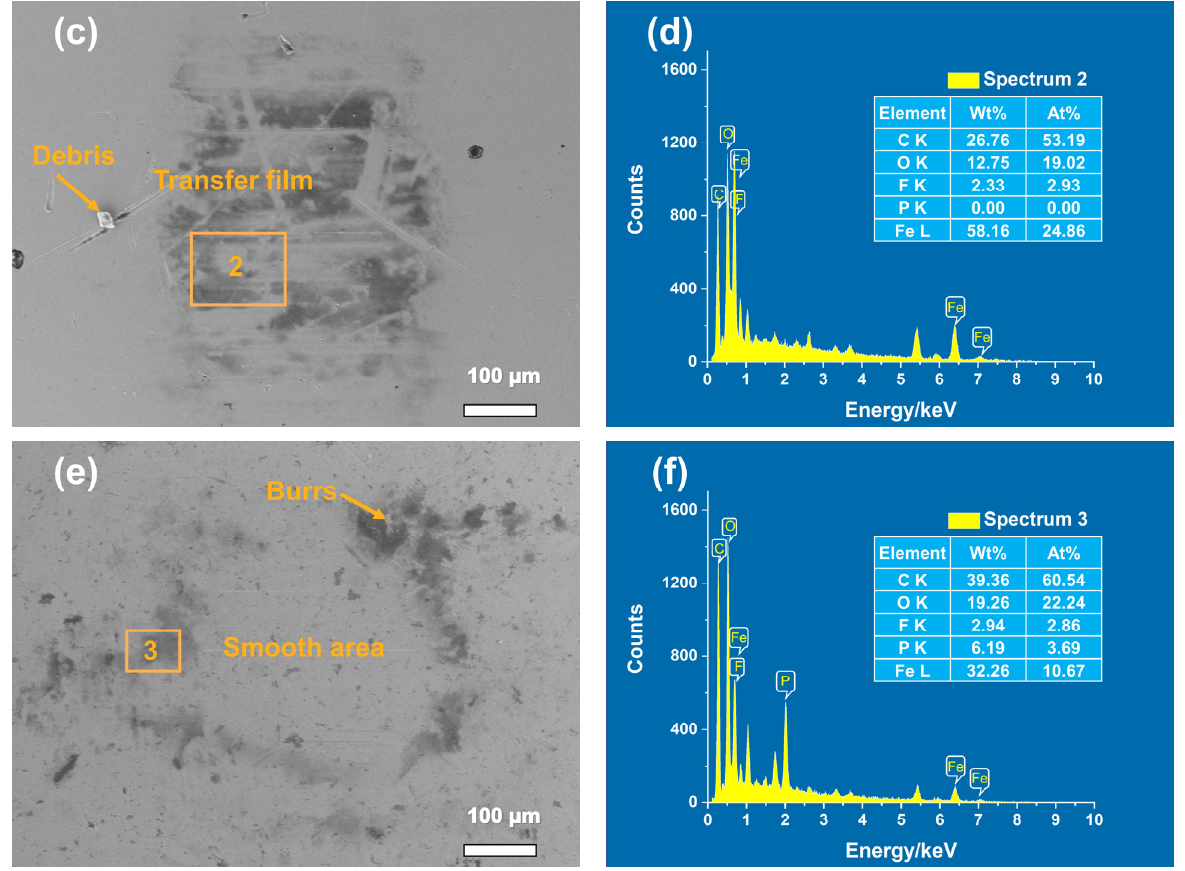
Figure 6. SEM-EDX micrographs of the bearing steel ball surfaces sliding against different com- posites: ( a ) pure PEEK; ( b ) EDX image of area 1; ( c ) PEEK/10 wt% PTFE; ( d ) EDX image of area 2; ( e ) PEEK/10 wt% PTFE/0.5 wt% BP; ( f ) EDX image of area 3. (EHT = 10.00 kV, Mag = 160×).